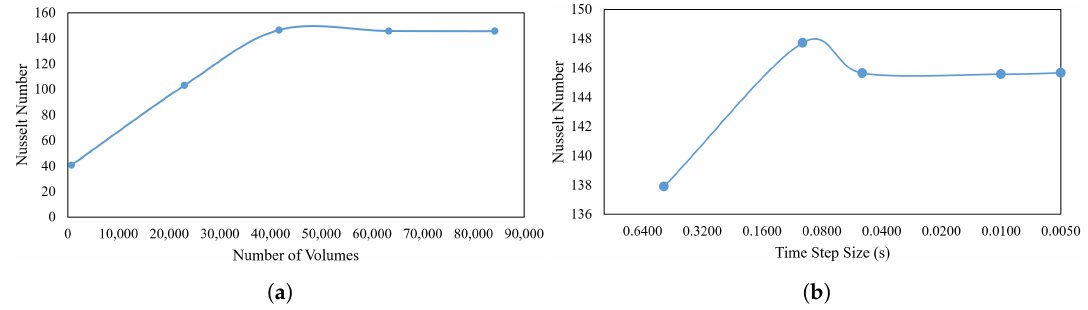
Figure 4. Independence studies. ( a ) Grid Independence; ( b ) Time Independence.